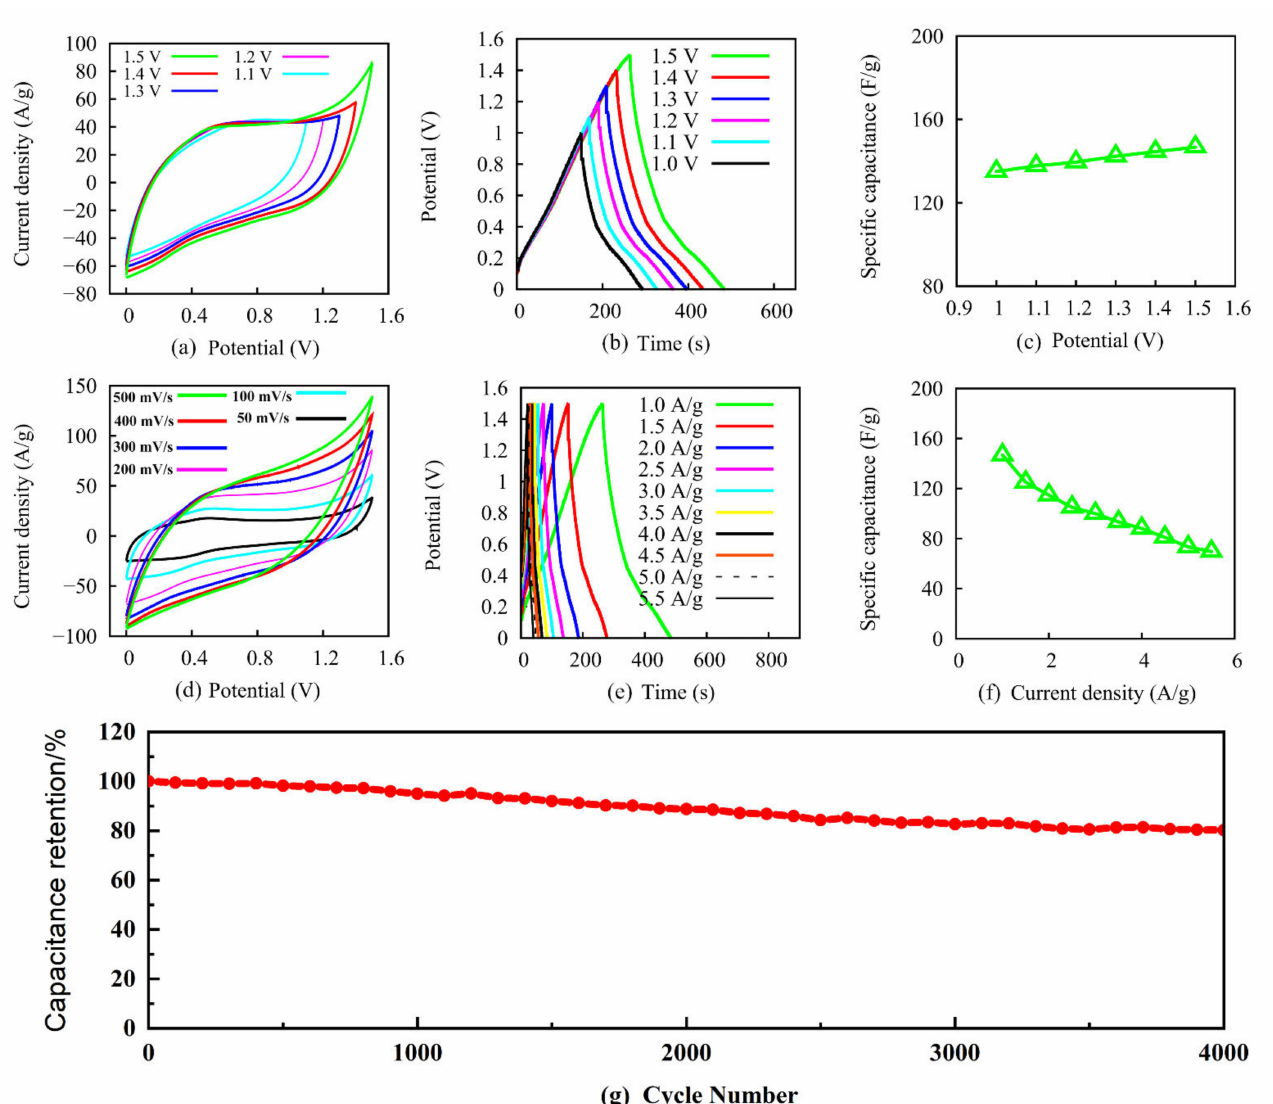
Figure 2. ( a ) CV curves of AgNWs@rGA/AgNWs@rGA supercapacitor under different voltage windows of 1.1, 1.2, 1.3, 1.4, and 1.5 V, respectively. ( b ) GCD curves of AgNWs@rGA//AgNWs@rGA under different voltage windows. ( c ) Specific capacitances versus scan voltage. ( d ) CV